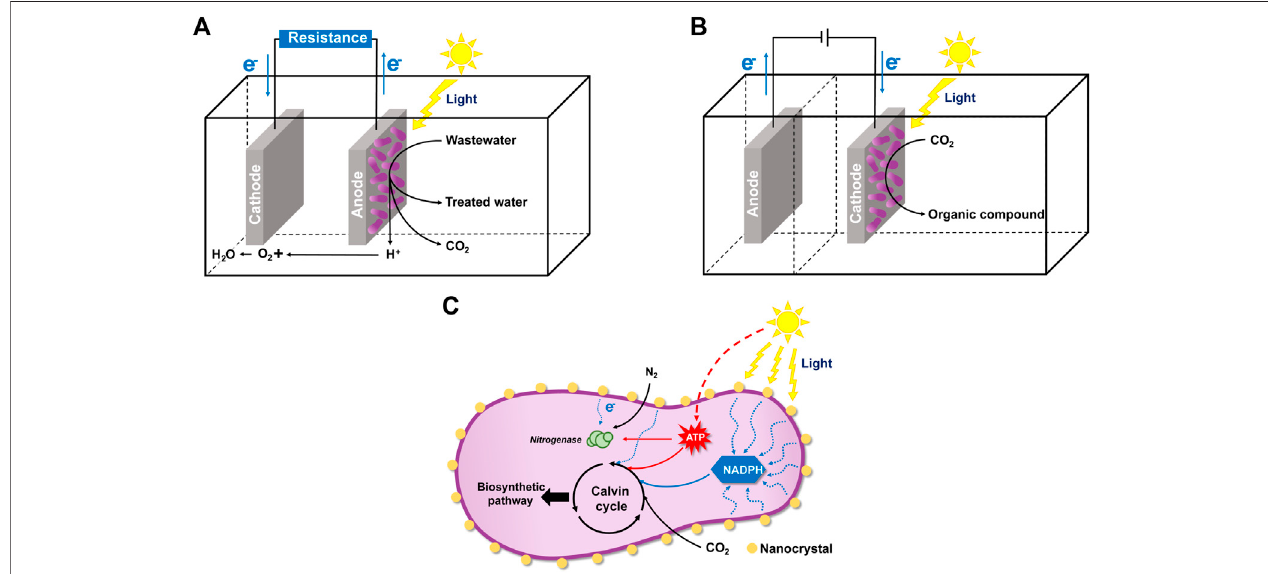
FIGURE 6 | Illustration of the microbial fuel cell (MFC) and microbial electrosynthesis (MES) of R. palustris and CdS- R. palustris hybrid system. (A) In the MFC system, R.palustris intheanodecanoxidizeorganicsubstratesinthewastewaterandreleaseelectronsandprotons.Electricitycurrentisgenerated,andtheprotonsare transferred to the cathode and react with oxygen to generate water. (B) In the MES system, the electrons from the cathode is absorbed by R. palustris for organic chemicals production from inorganic carbon dioxide and light energy. (C) In the CdS- R. palustris hybrid system, R. palustris can absorb electrons from the CdS nanoparticles (NPs) coated on its cell